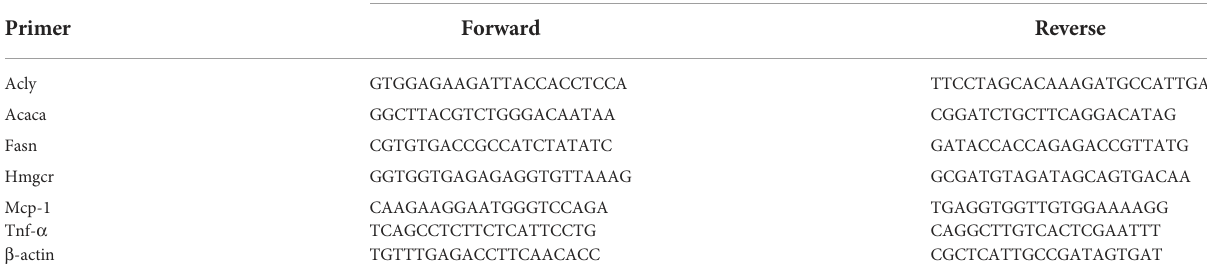
TABLE 1 Oligonucleotide primers used in the